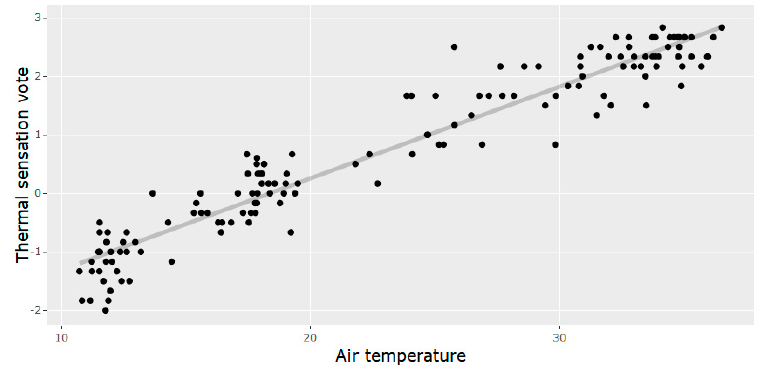
Figure 6. Correlation between thermal sensation vote and air temperature.